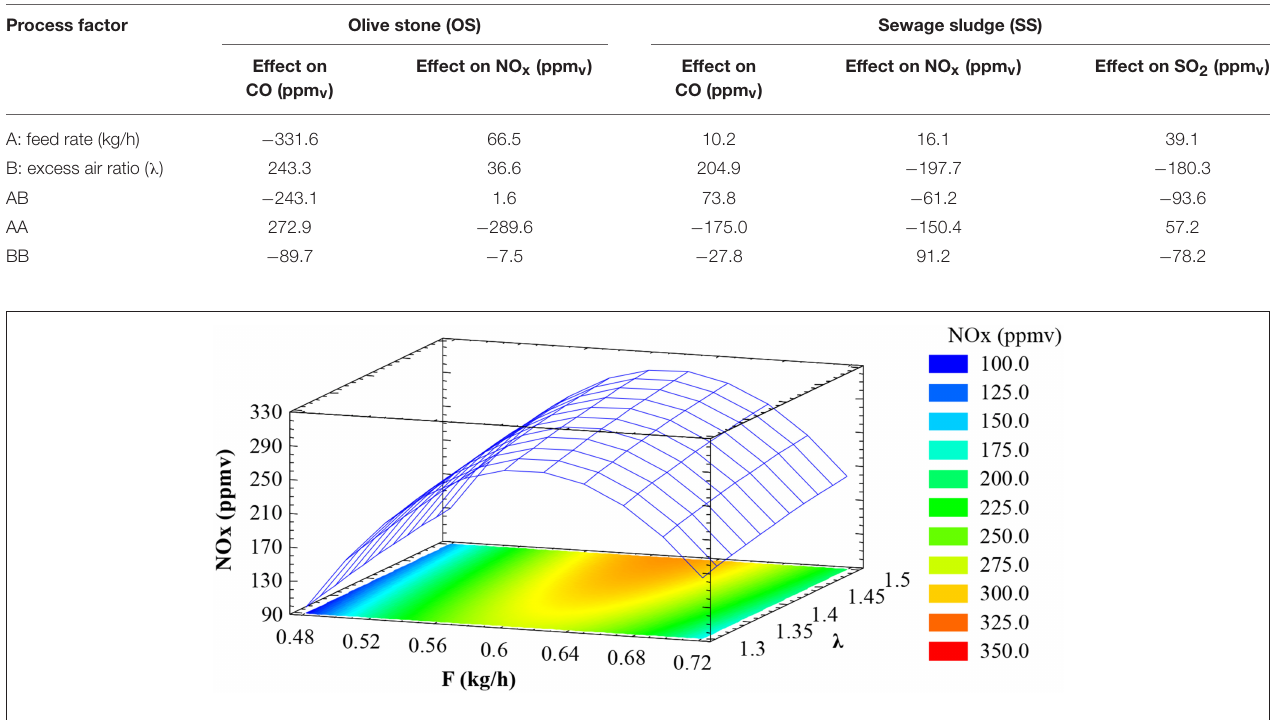
FIGURE 6 | Response surface plot showing the effect of feed rate (F) and excess air ratio ( λ ) on NOx emissions of OS fuel.